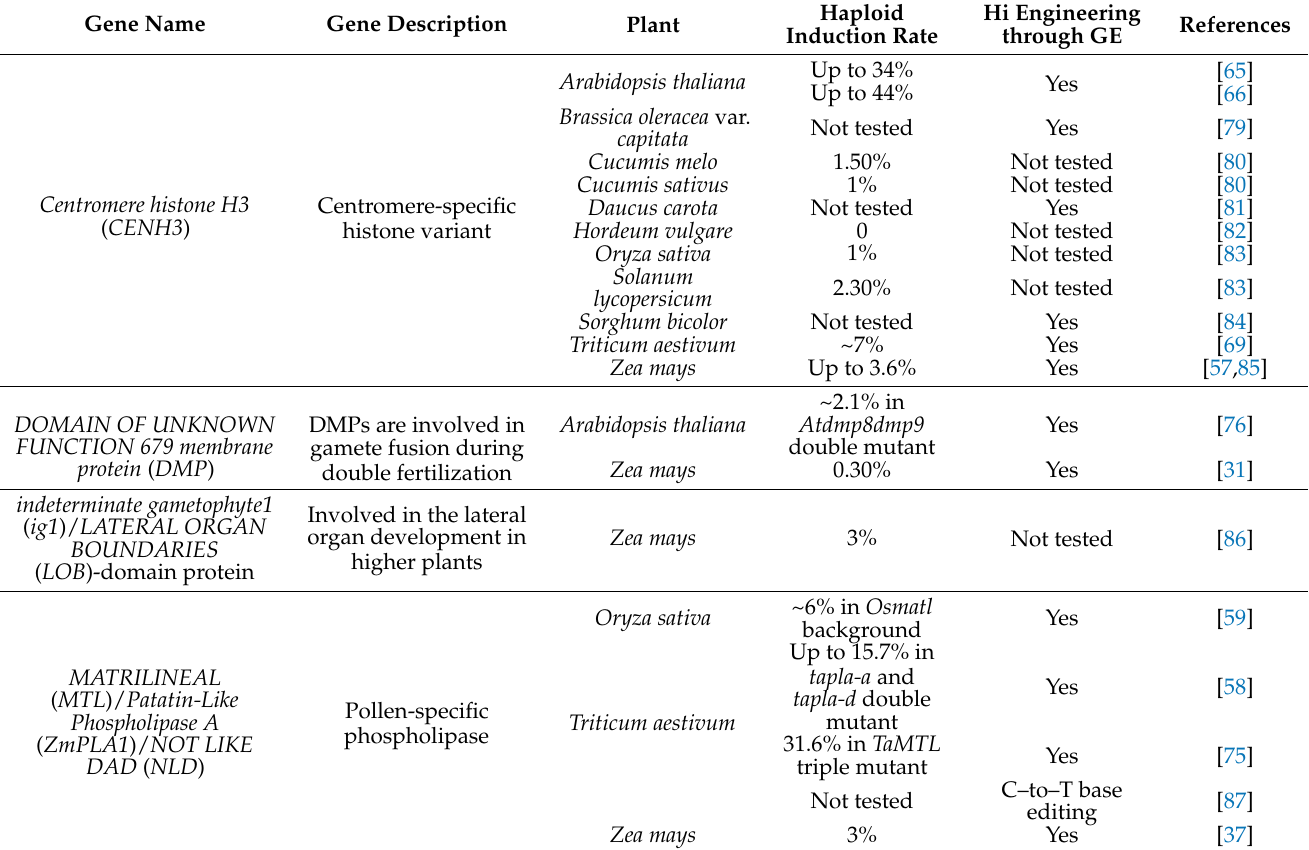
Table 1. Genes involved in haploid induction in